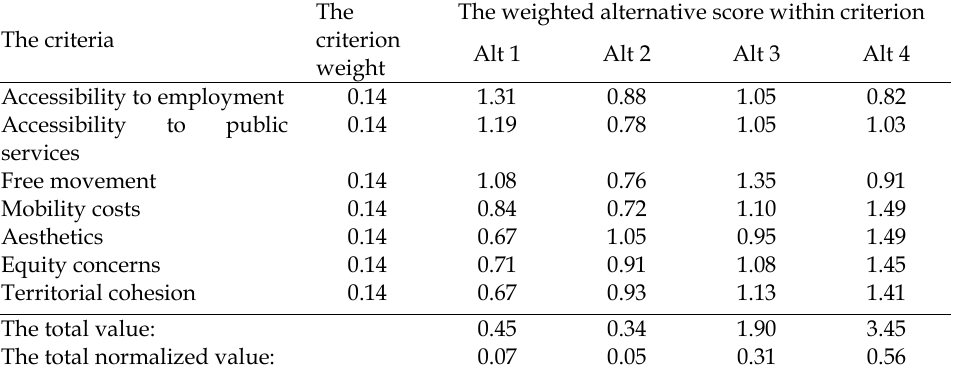
Table 4. Normalised score of the alternatives assessed: social sustainability